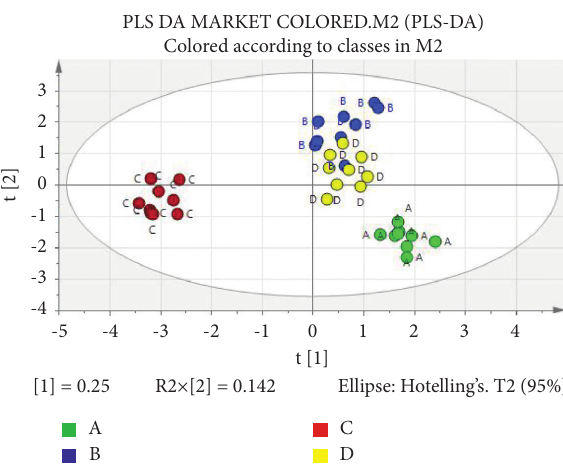
Figure 3: The partial least squares-discriminant analysis (PLS-DA) score plot of control and market samples of colored chicken in terms of proximate, color, and texture properties. Colored circles are represented by A � control colored chicken (green); B � market 1 (blue); C � market 2 (maroon); D � market 3